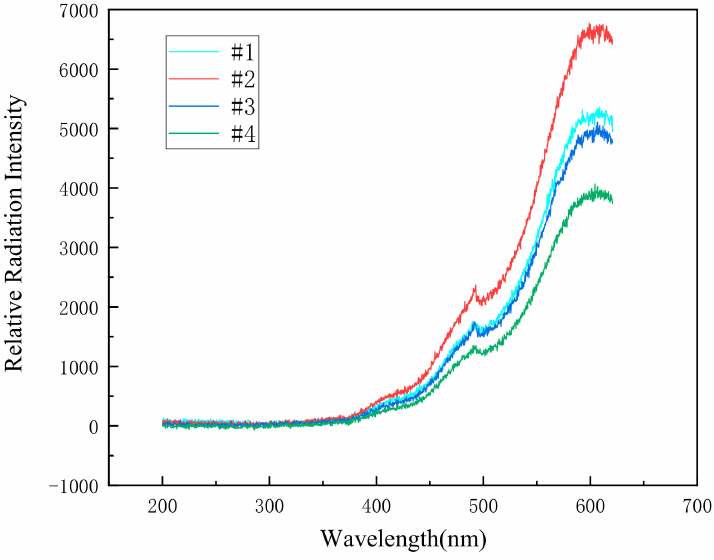
Figure 6. The spectrums of the reaction flame of four different specimens at a drop height of 200 cm.